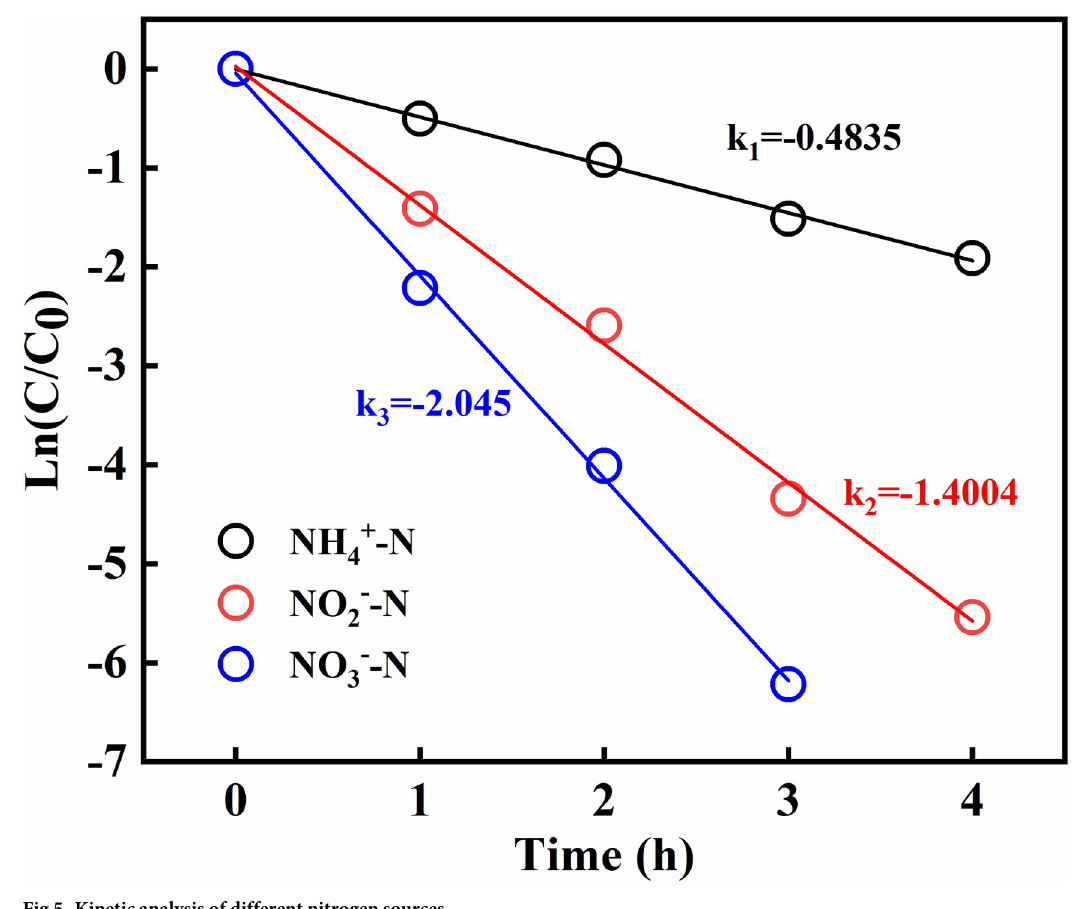
Fig 5. Kinetic analysis of different nitrogen sources.